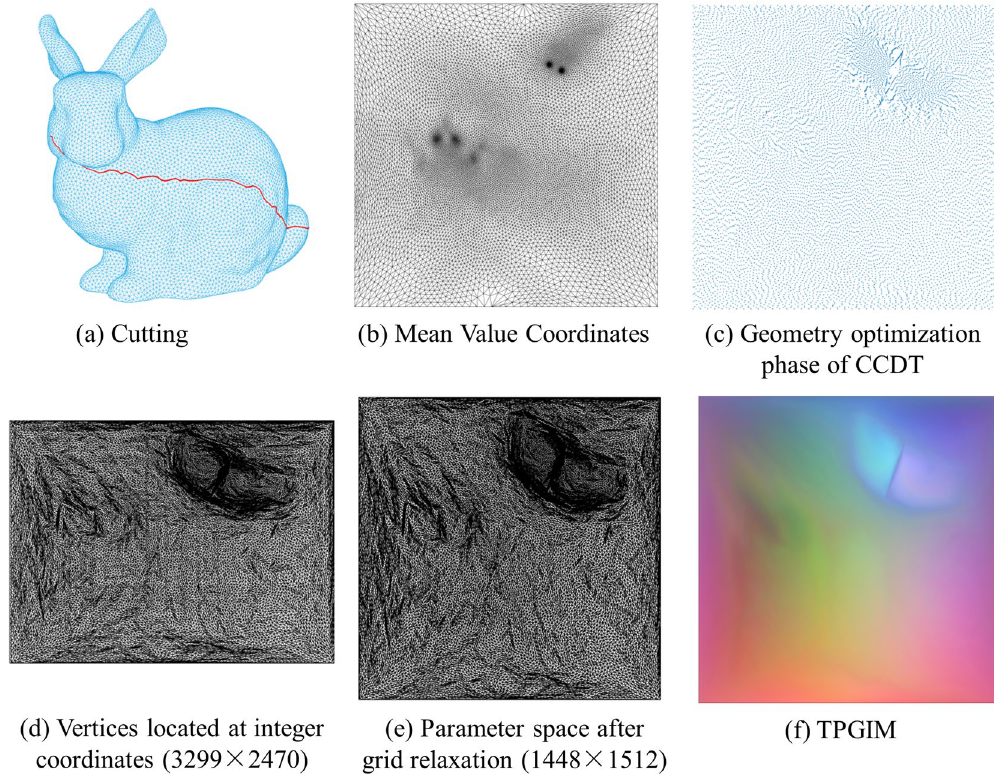
Figure 5. The whole pipeline of moving vertices to the integer